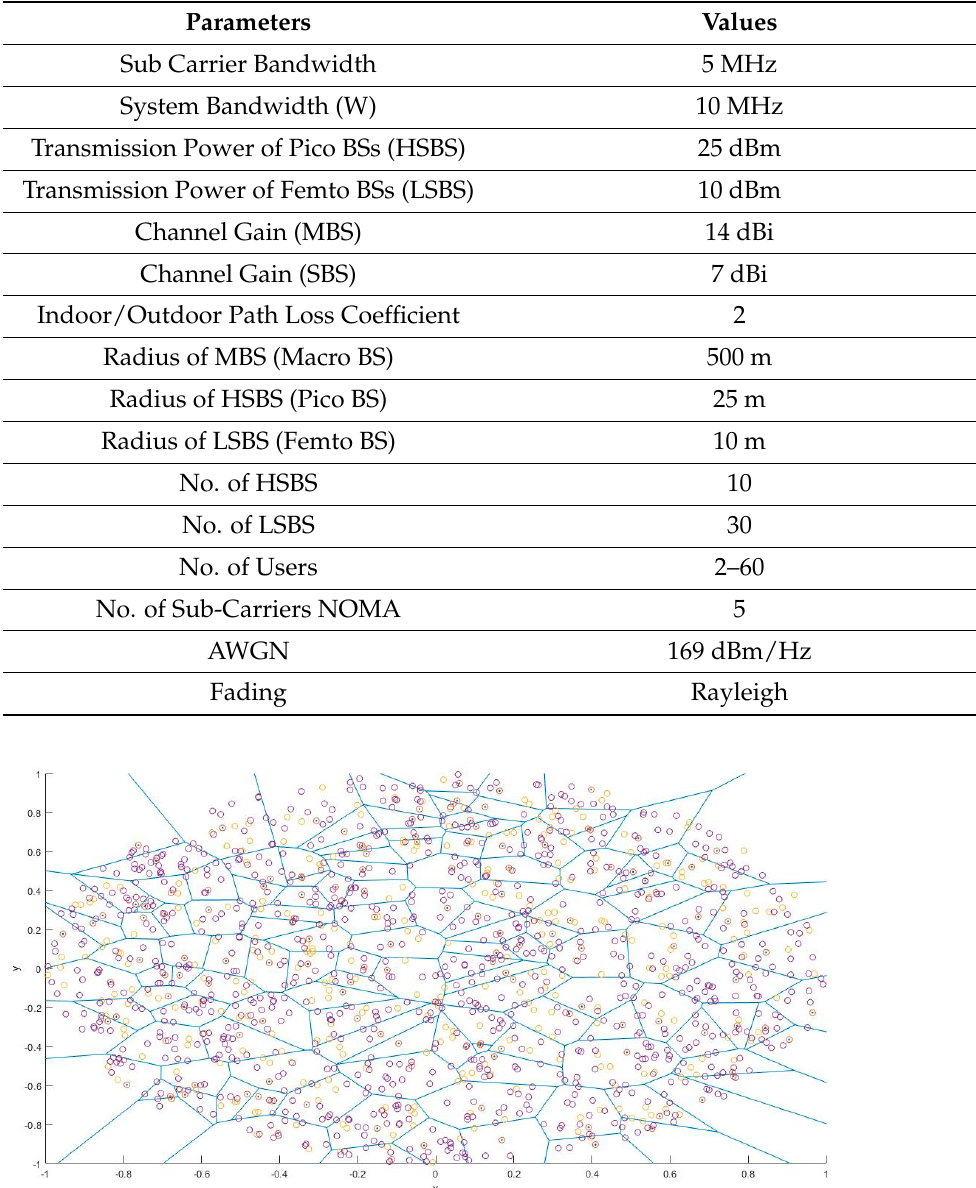
Figure 4. ( a ) Clustered PD-NOMA, ( b ) direct PD-NOMA, and cooperative PD-NOMA within the clusters.